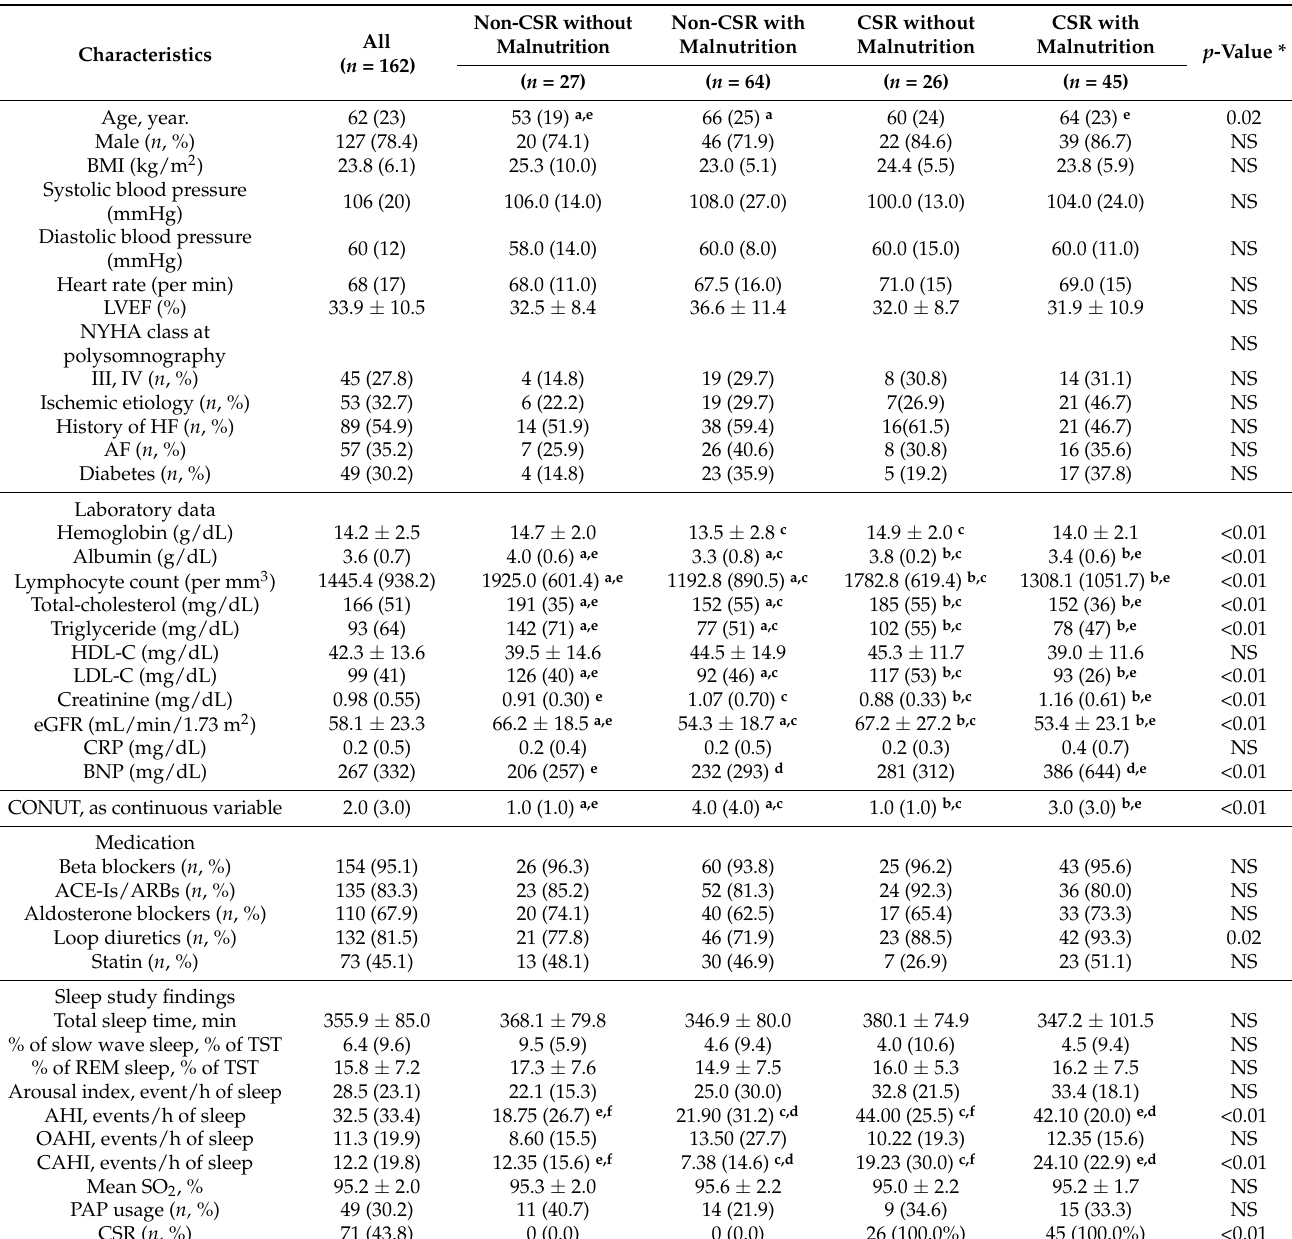
Table 1. Characteristics of the study